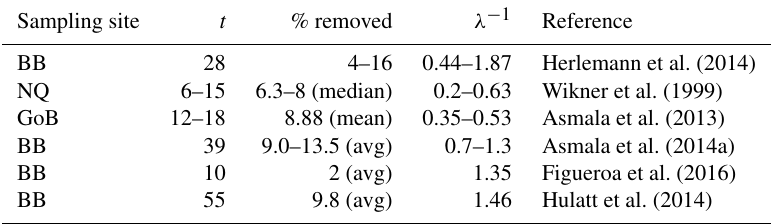
Table 2. Removal of terrestrial DOC in incubation studies from the Gulf of Bothnia area.